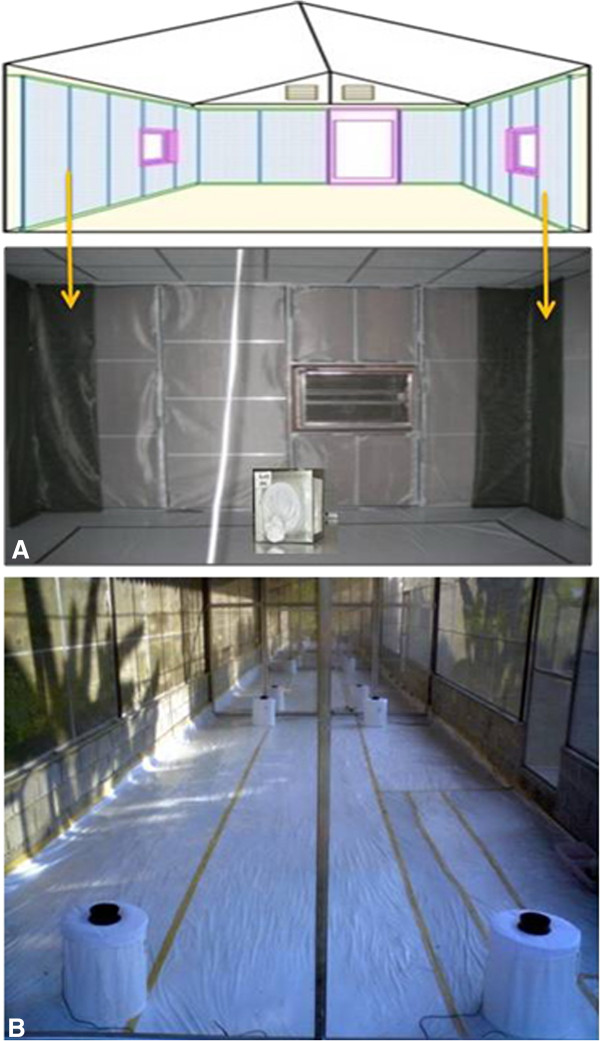
(A) Positioning of treated material and exposure of Aedes aegypti in huts; (B) Mosquito trapping with BG-Sentinel™ traps in the screen house.